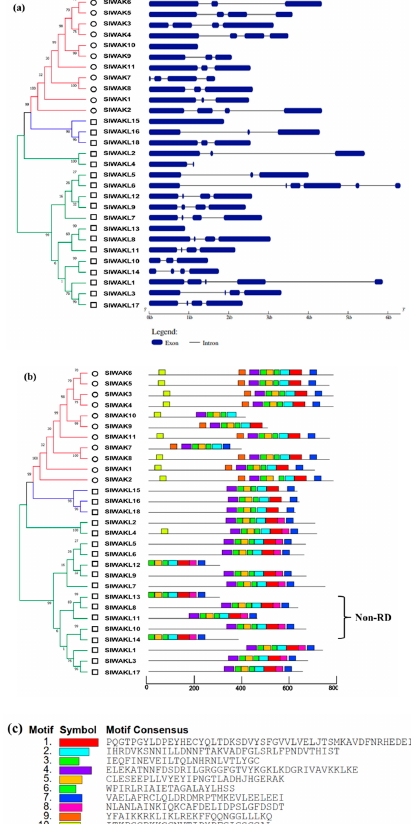
Figure 5. Gene structure and motif patterns of the tomato SlWAK-RLK genes. ( a ) Gene structure of the tomato SlWAK-RLK genes generated using Gene Structure Display Server (http://gsds.cbi.pku.edu.cn). The yellow block indicates the coding sequence (CDS), and the black line represents the intron. The lengths of the DNA sequences are indicated by the scale bar. The red number in front of the gene ID represents the group to which the gene belongs in the Phylogenetic analysis; ( b ) Conserved motif analysis of the tomato SlWAK-RLK genes generated using MEME (http://meme-suite.org/). Black solid line represents corresponding SlWAK-RLKs and their size. Various colored boxes indicate different motifs; ( c ) The motif consensus of various colored boxes. Numbers 1–11 represent the grouping of the gene in the evolutionary tree in Figure 3.